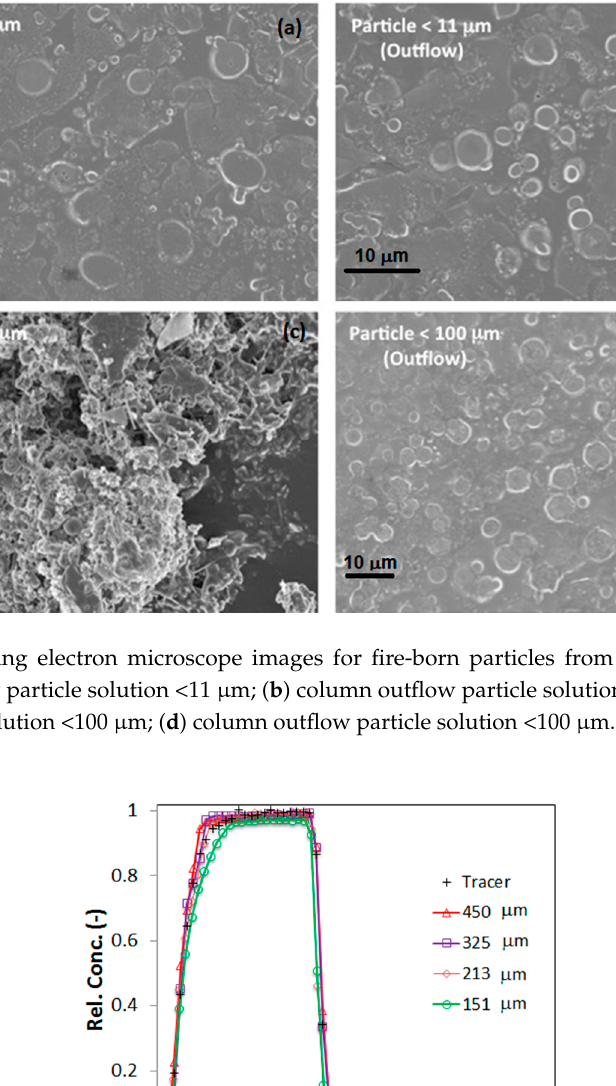
Figure 5. Representative FBP breakthrough curves from column experiments using extinguishing water collected at site 2 after filtration using two different particle sizes.